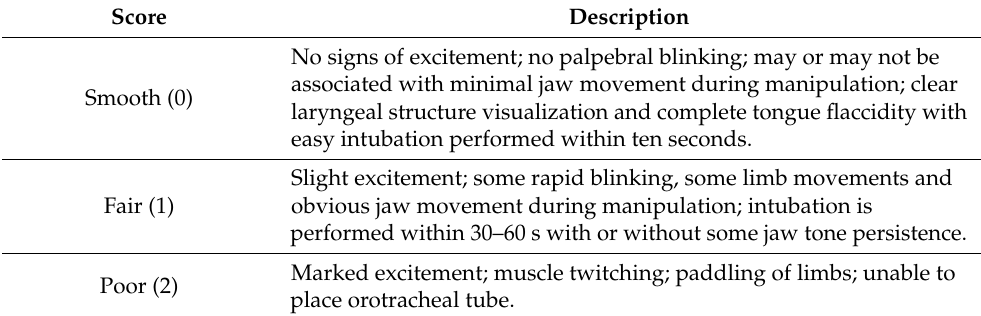
Table A1. Induction quality scoring